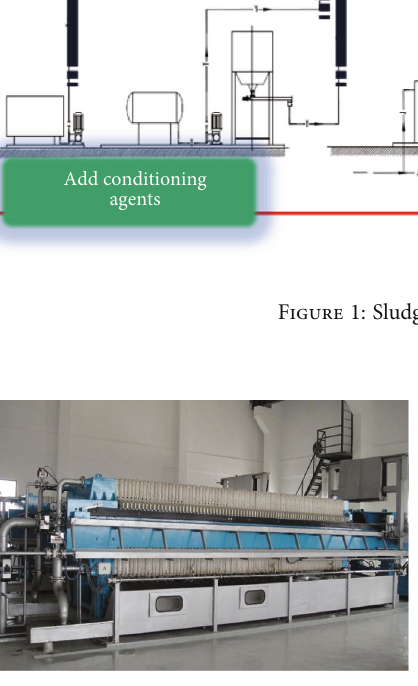
Figure 2: Diaphragm fi lter press.